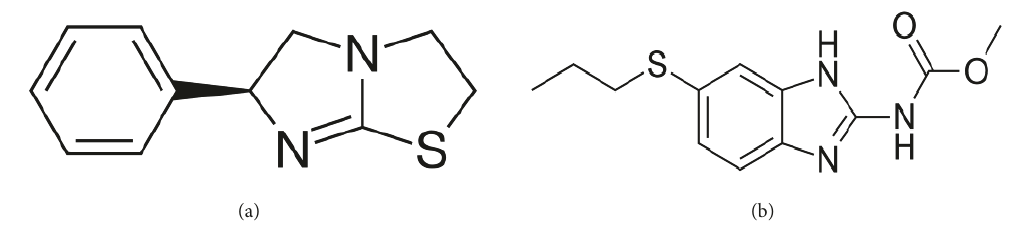
Figure 1: Chemical structures of (a) levamisole hydrochloride and (b)